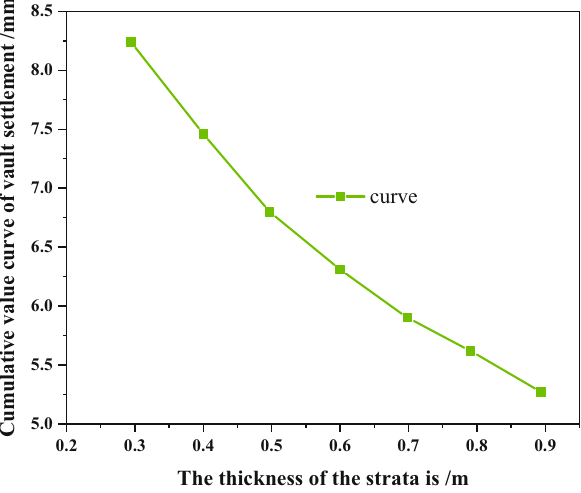
Figure 3: Cumulative value curve of settlement at the vault with di ff erent layer thickness.